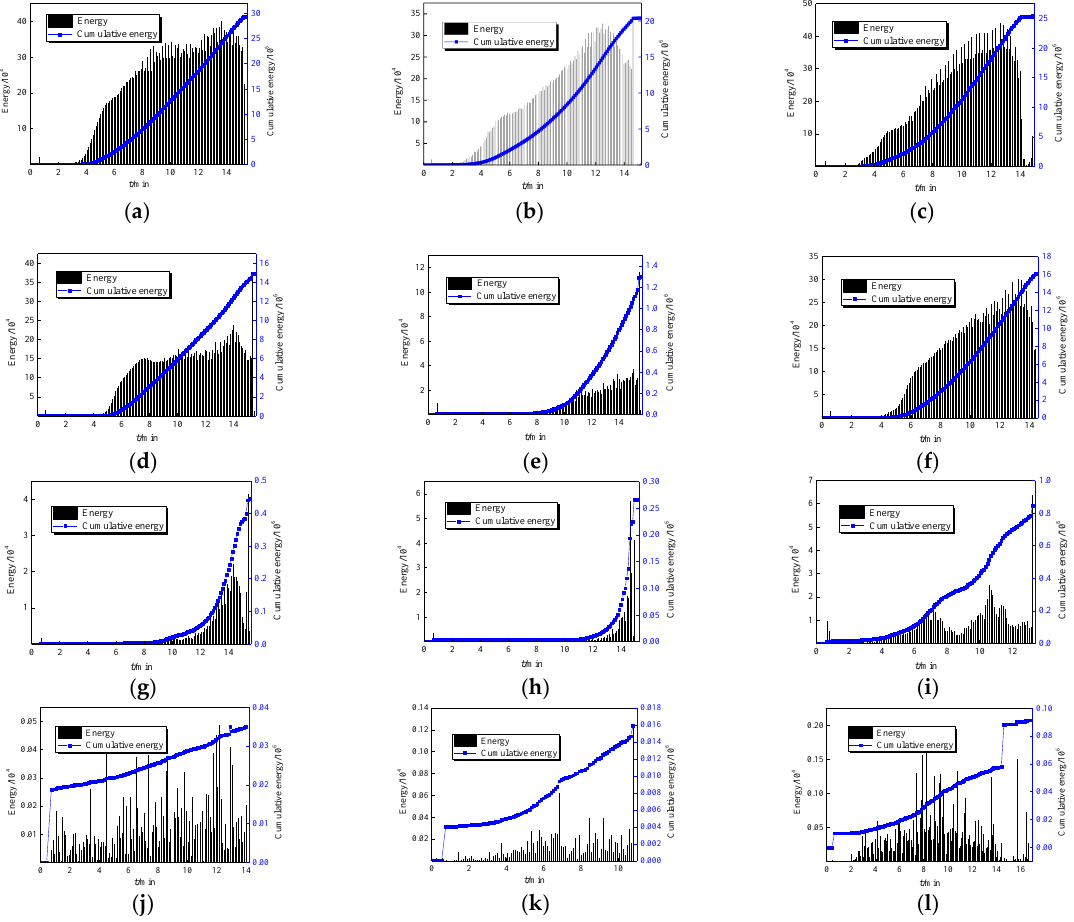
Figure 8. Acoustic emission energy and cumulative energy versus time curve including unloading points: ( a ) 0%, ( b ) 40%, ( c ) 45%, ( d ) 50%, ( e ) 55%, ( f ) 60%, ( g ) 65%, ( h ) 70%, ( i ) 75%, ( j ) 80%, ( k ) 85%, ( l ) 90%.